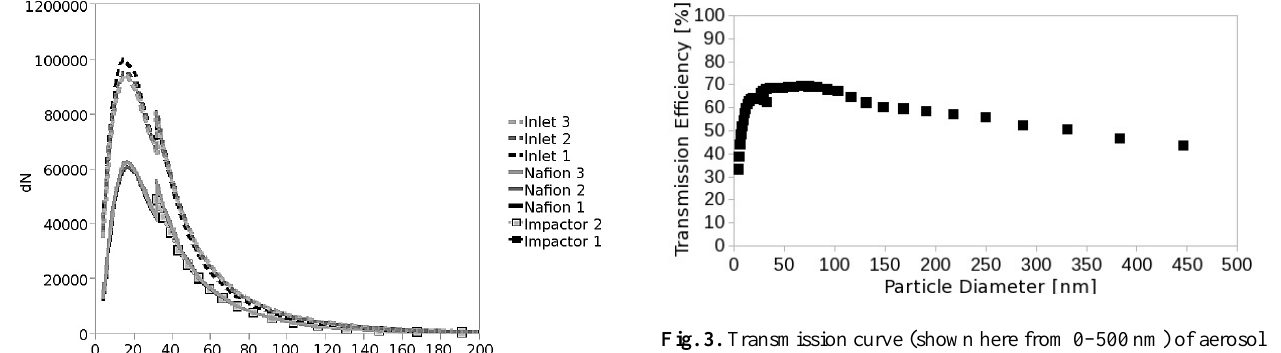
Fig. 3. Transmission curve (shown here from 0–500nm) of aerosol particles through the MINC inlet system.